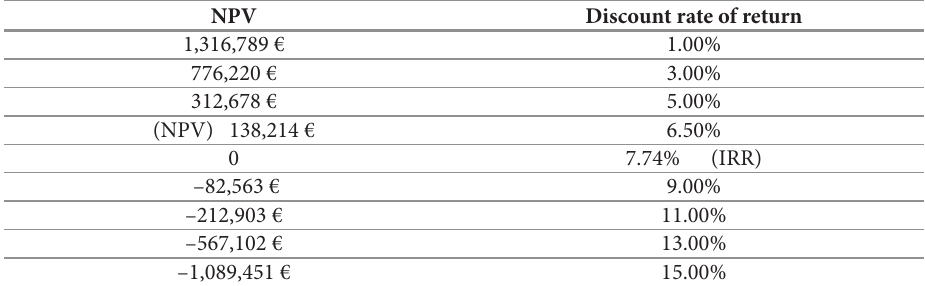
Table 2. Sensitivity analysis of the discount rate of return